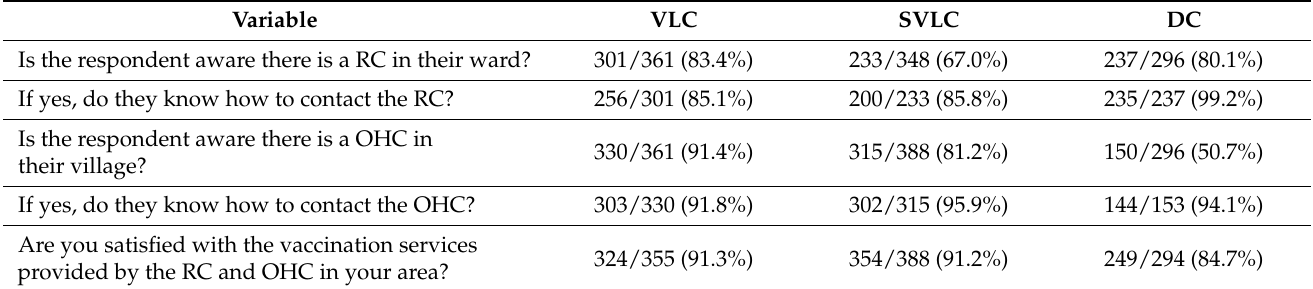
Figure 5. Respondent’s perceptions regarding the location of the household relative to the central point clinic. CPV = centralized pulsed vaccination, VLC = village-level continuous decentralized vaccination, SVLC = sub-village level continuous decentralized vaccination, DC = discretionary continuous decentralized vaccination. Table 3. Respondent perceptions regarding the dog vaccination services under the three sub-strategies of the DCV.